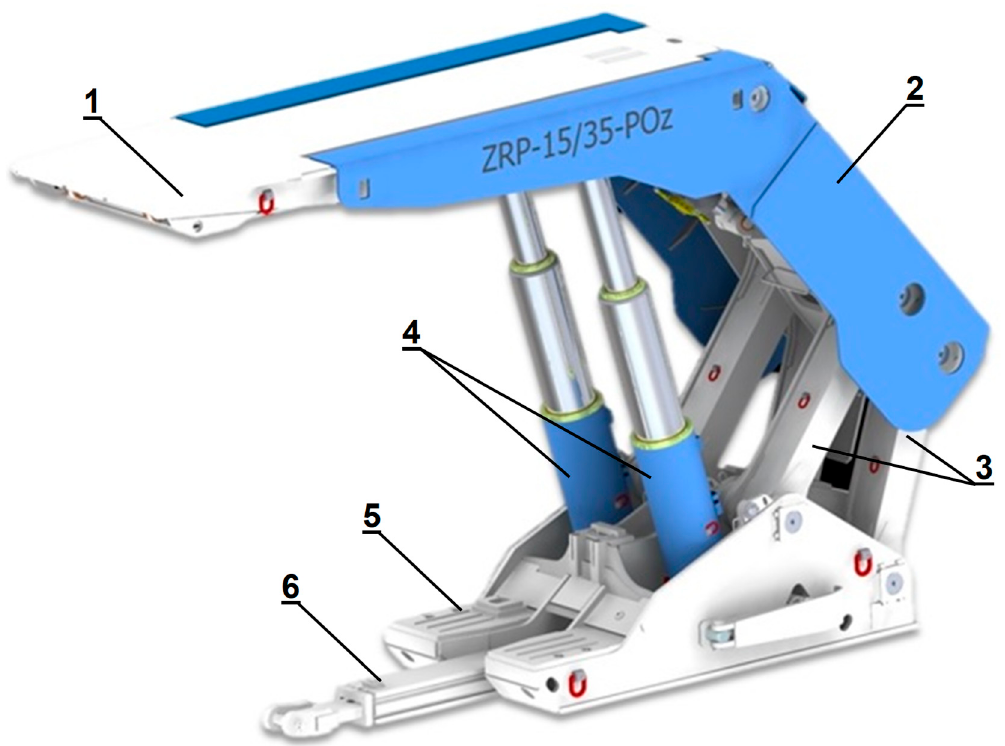
Figure 1. Section of the powered roof support: 1, canopy; 2, shield support; 3, lemniscate tie rods; 4, leg; 5, floor base; 6, shifting system.